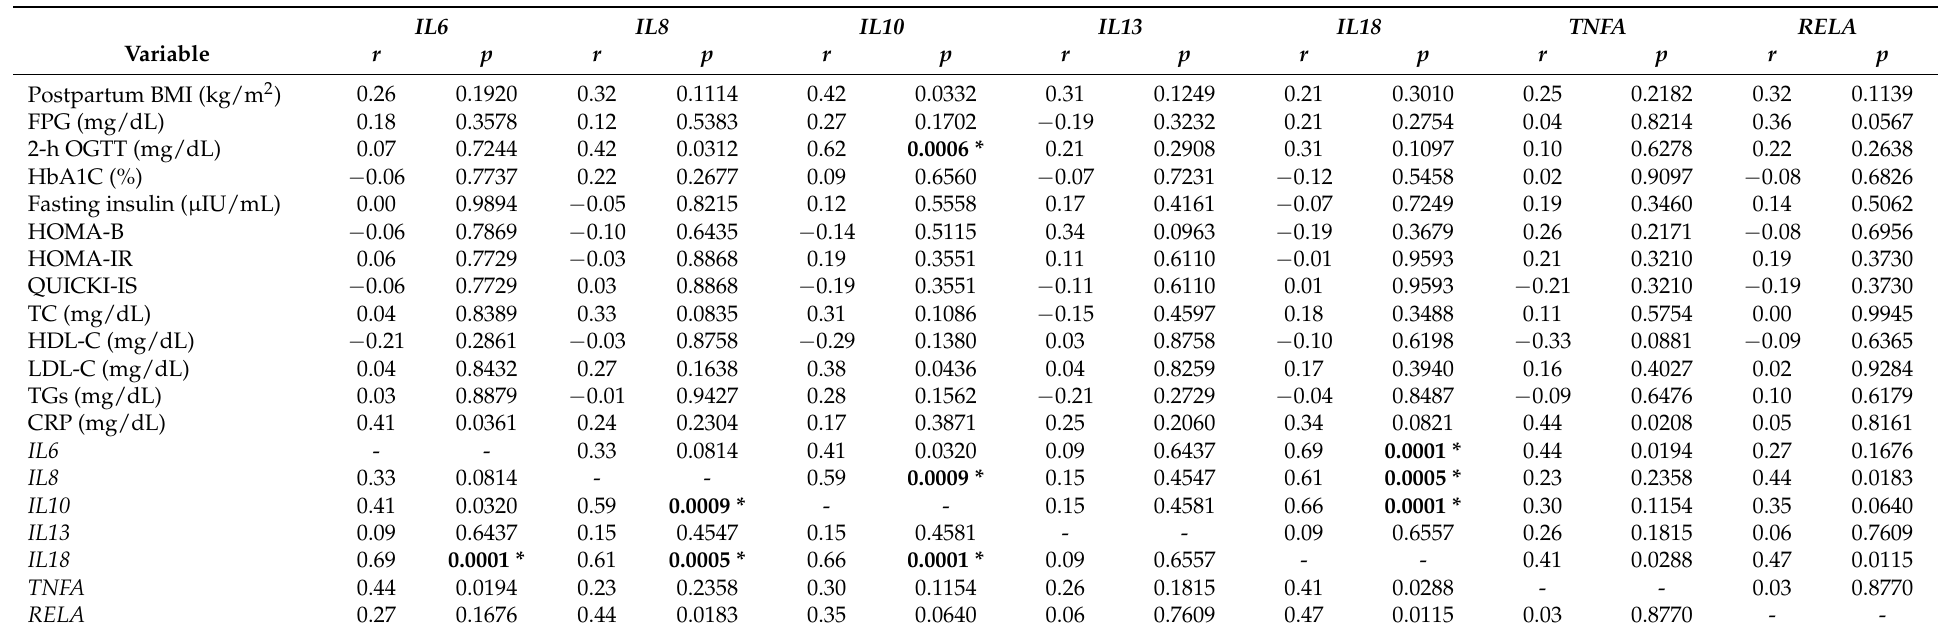
Table 4. Correlation study through Spearman’s linear regression analysis at 1-year postpartum ( n =